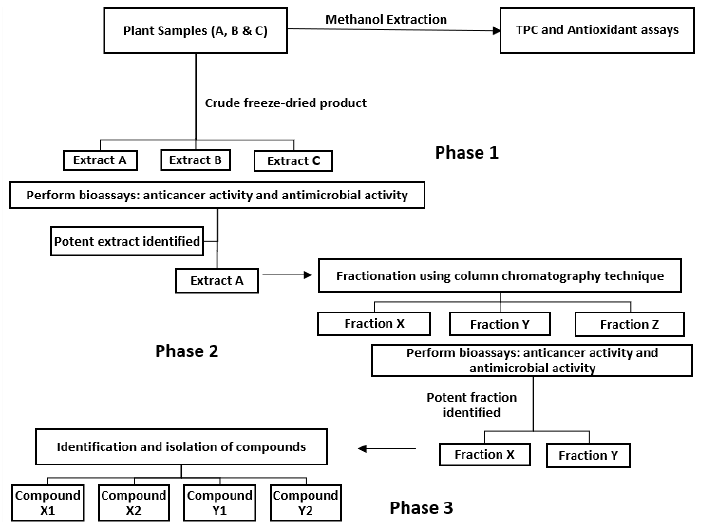
Figure 1. Bioassay guided fraction protocol design [3]. Reproduced under Creative Commons CC-BY-NC-ND